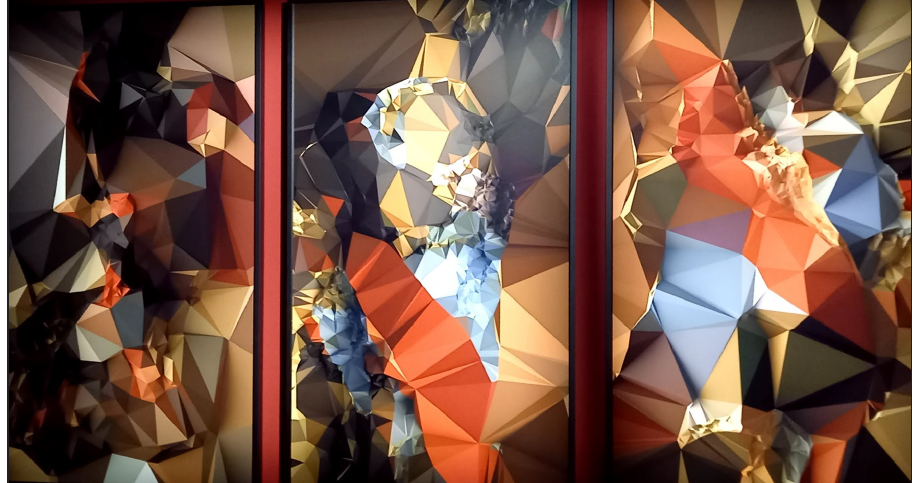
Figure 3: Davide Quayola. Iconographies #81: Adoration after Botticelli, 2016. Photo Susan Broadhurst, 29 th September,